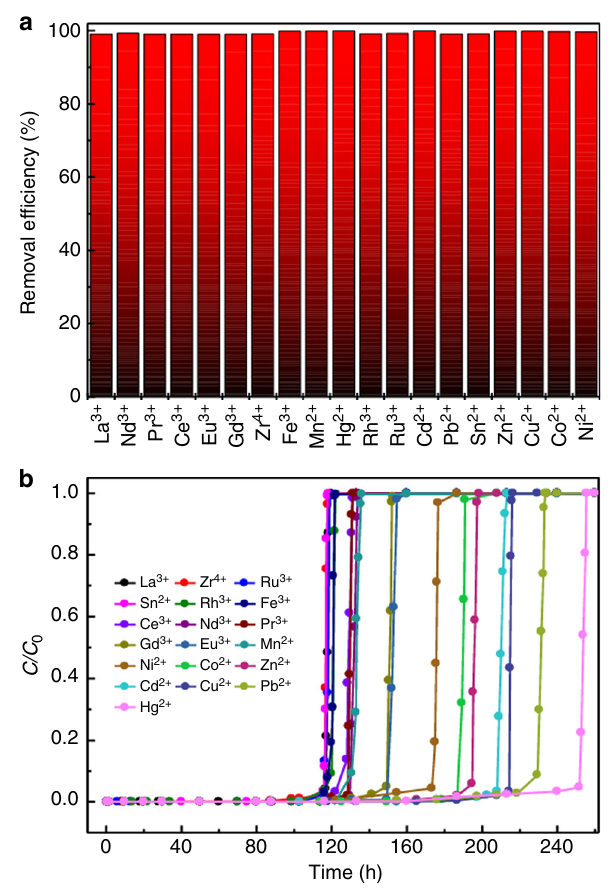
Fig. 5 Capture performance of MOF-808-EDTA in multi-component systems. a Simultaneous removal ef fi ciency for 19 metal ions in batch adsorption. b Breakthrough curves in the fi xed bed